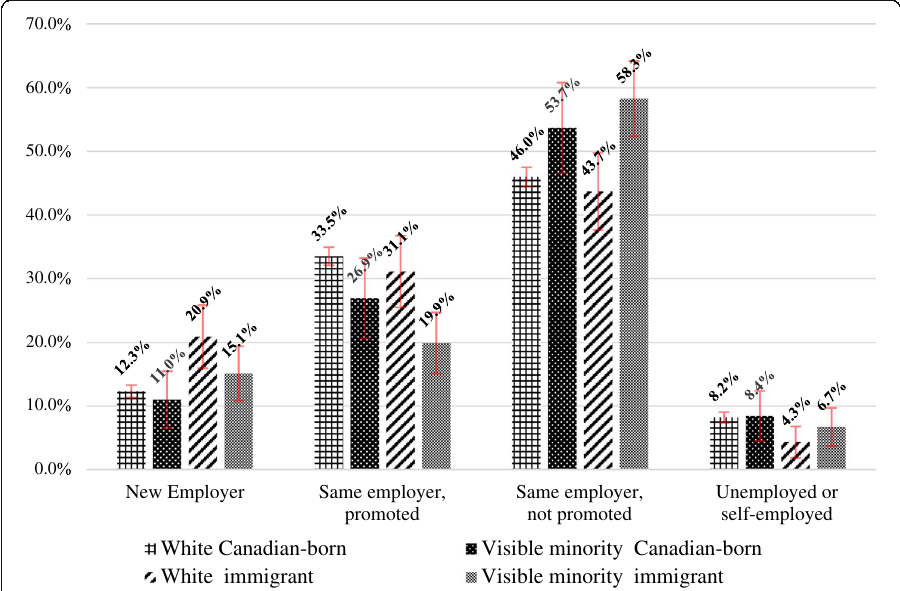
Fig. 1 Labor market transitions by group. Notes : The figure displays the weighted fraction of each group making a particular transition using the employee weights provided by Statistics Canada along with 95% confidence